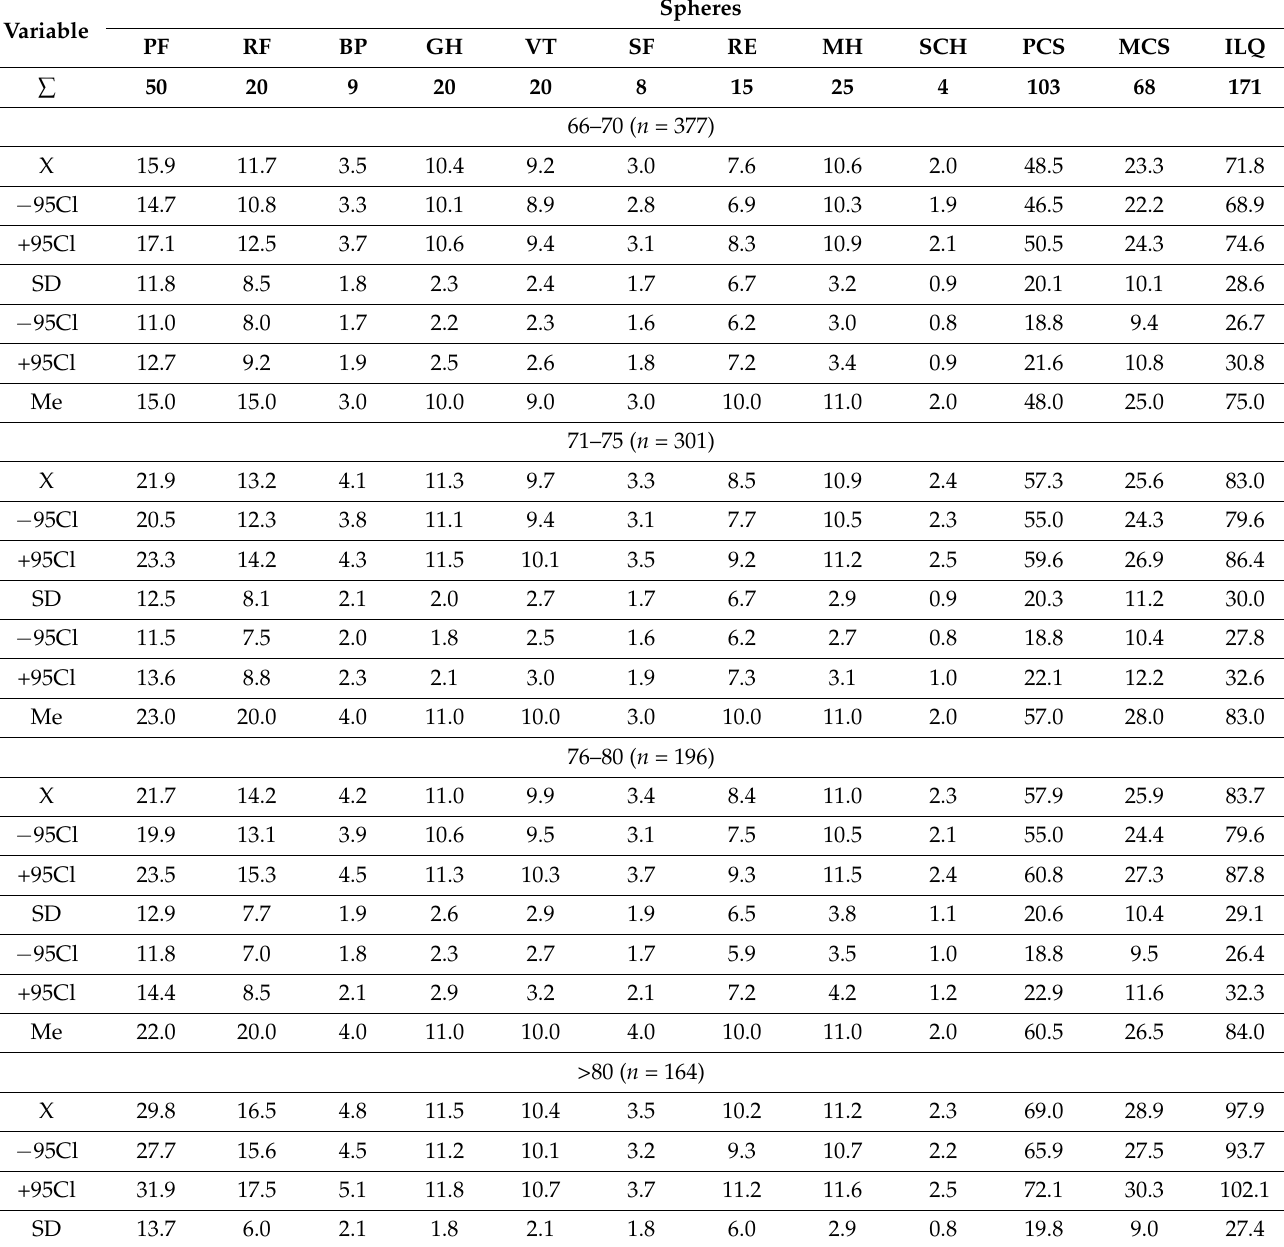
Table 3. The average level of the HRQoL in individual spheres, considering the intergroup averages (point